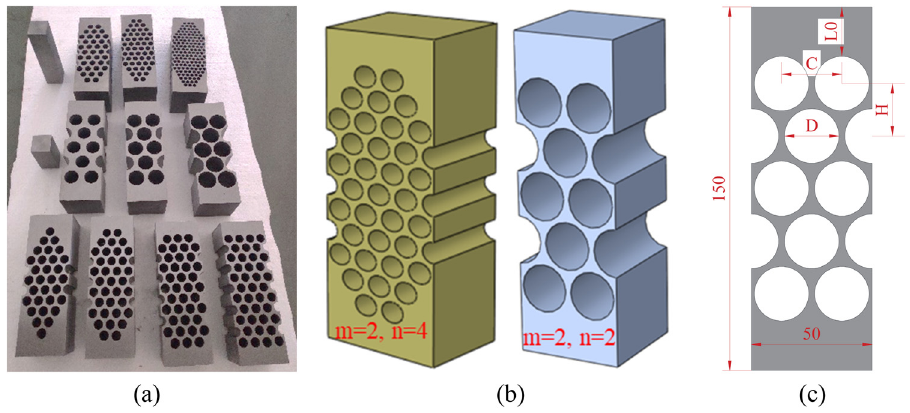
Figure 2: Test specimens: ( a ) CY block, ( b ) 3D view, and ( c ) dimensions.